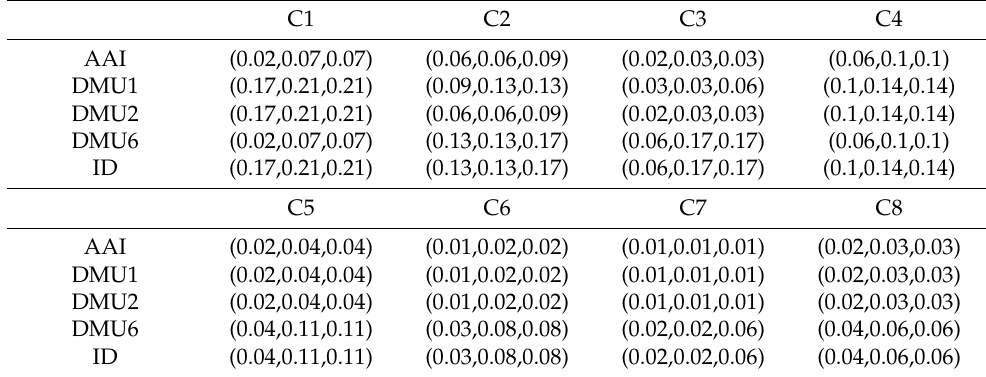
Table 12. Fuzzy weighted normalized decision